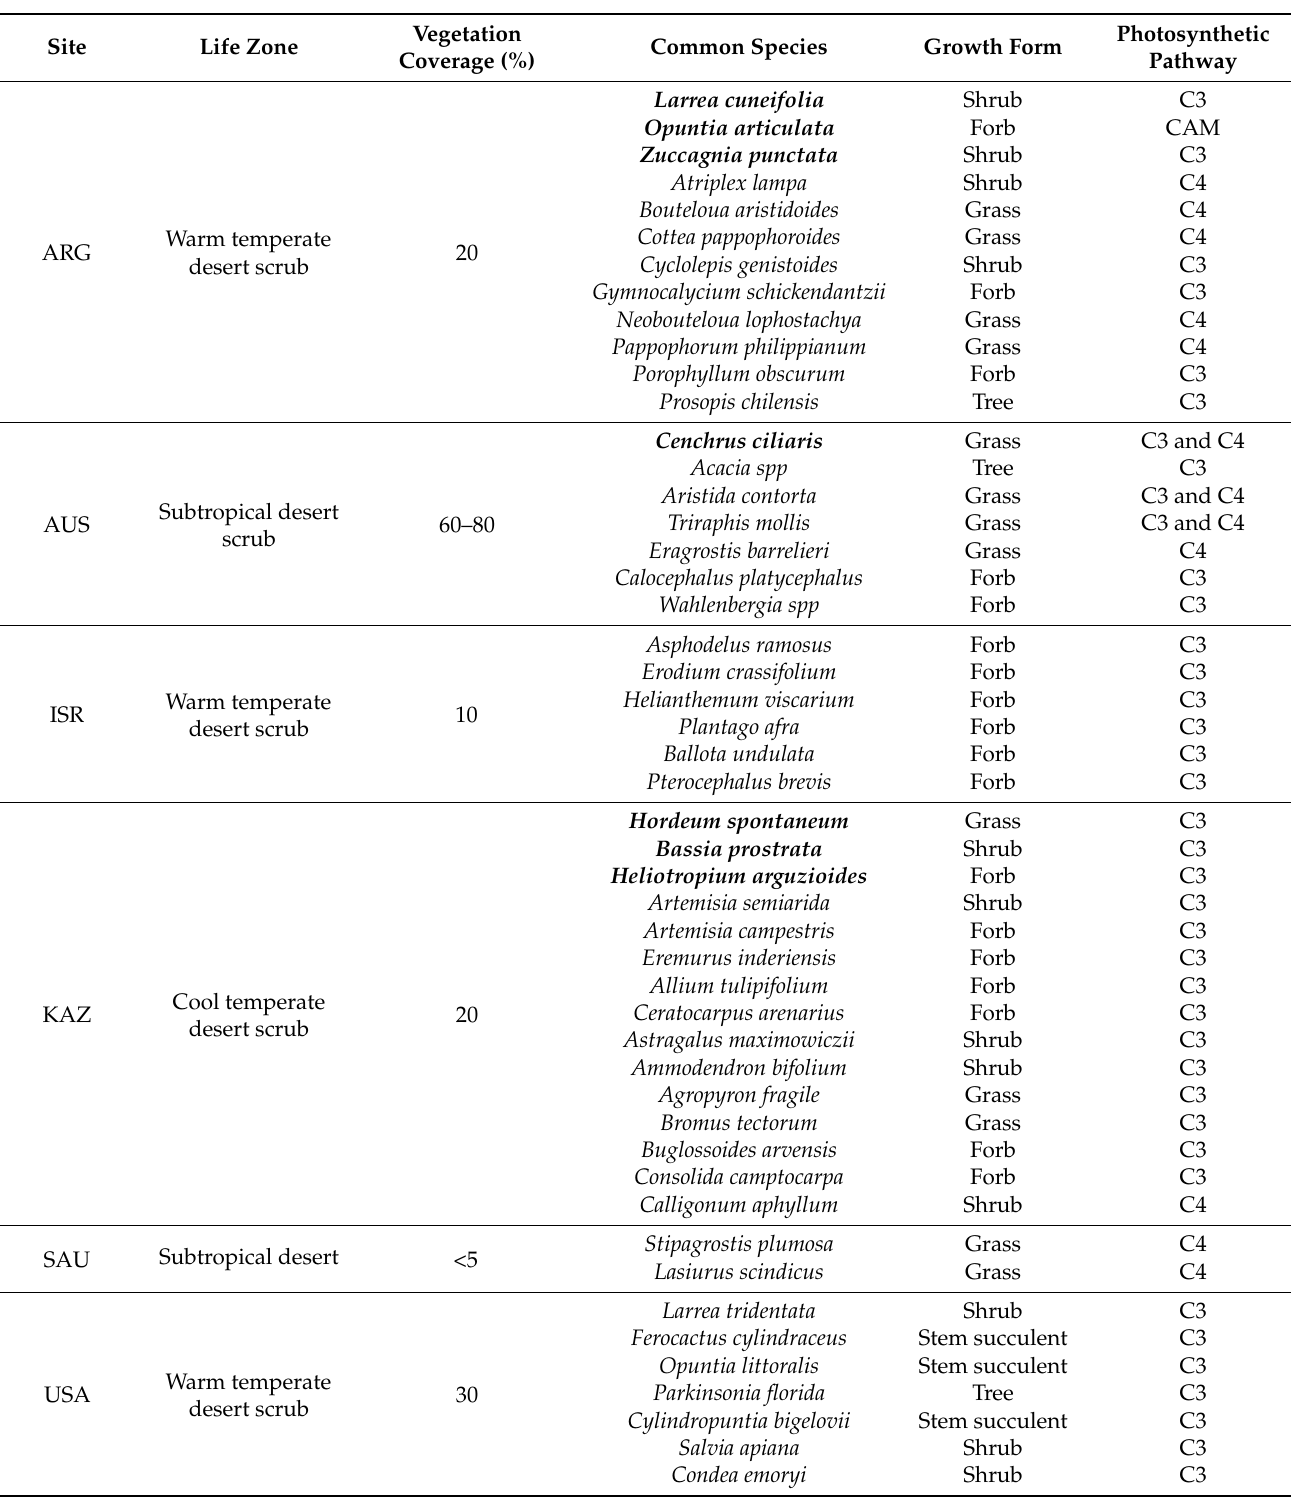
Table 2. Life zone and common plant species in study sites. Taxonomy follows “The Plant List” (www.theplantlist.org). Abbreviation spp is used when it was possible to recognize only genus. Dominants are indicated in bold. Life zone is from [37]. The C3, C4, and CAM (Crassulacean acid metabolism) photosynthesis models are based on a common photosynthetic core with additional fluxes to capture the spatial and temporal separations of CO 2 uptake and